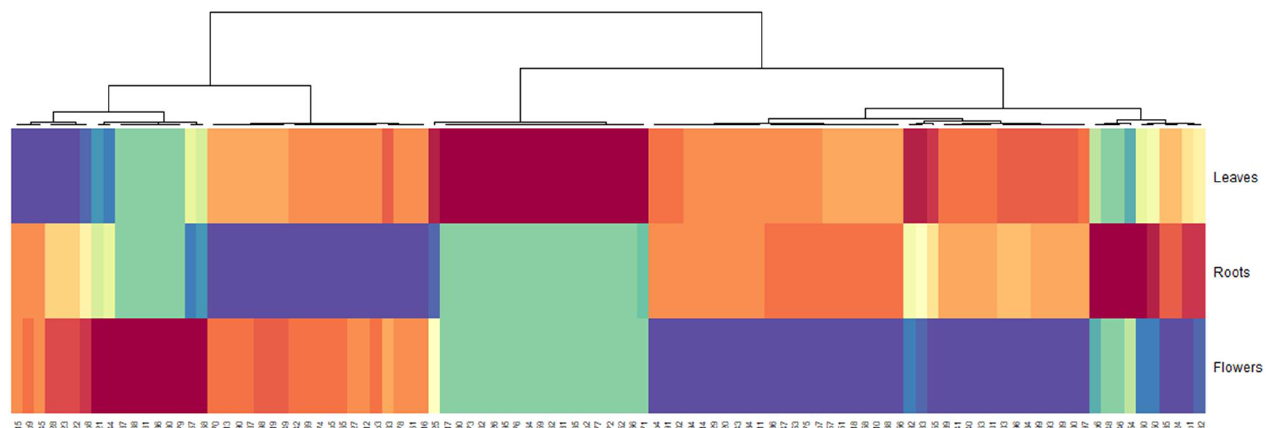
Figure 1. Global overview of the metabolite’s contrasts among Tanacetum balsamita samples (Clustered Image Map).